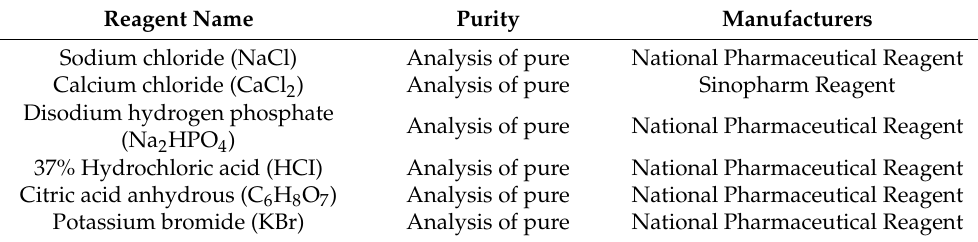
Table 1. Main experimental